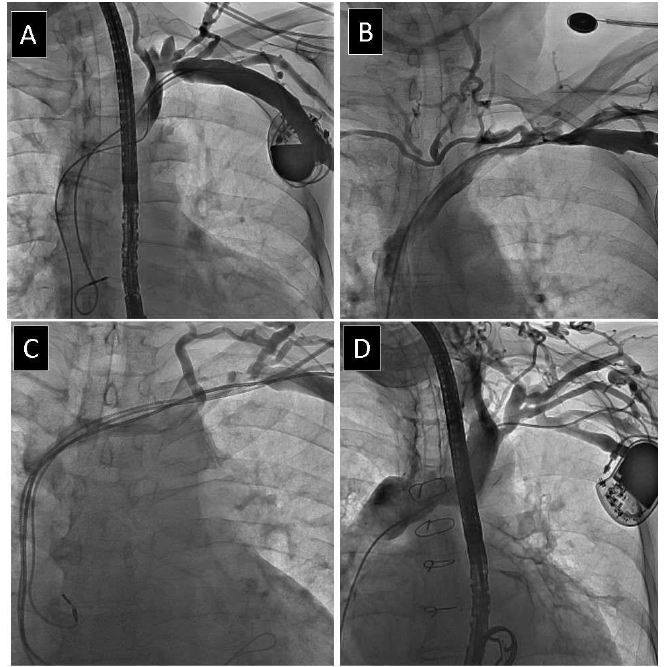
Figure 2. Different degree of obstruction of subclavian vein. ( A ) Mild narrowing of subclavian vein. ( B ) Moderate narrowing of subclavian vein. ( C ) Severe narrowing of subclavian vein. ( D ) Complete occlusion of subclavian vein.